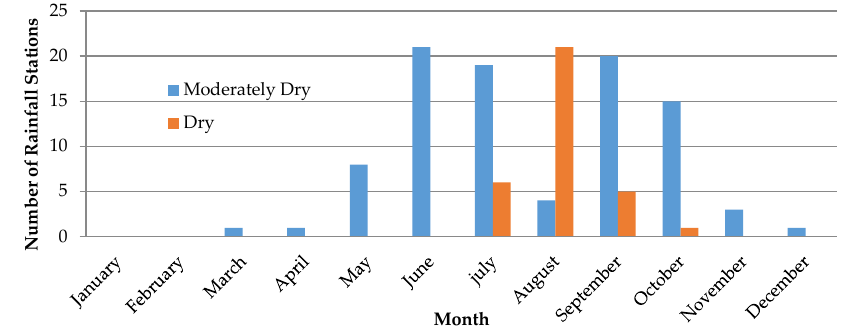
Figure 6. Number of rainfall stations experiencing moderately dry or worse conditions.